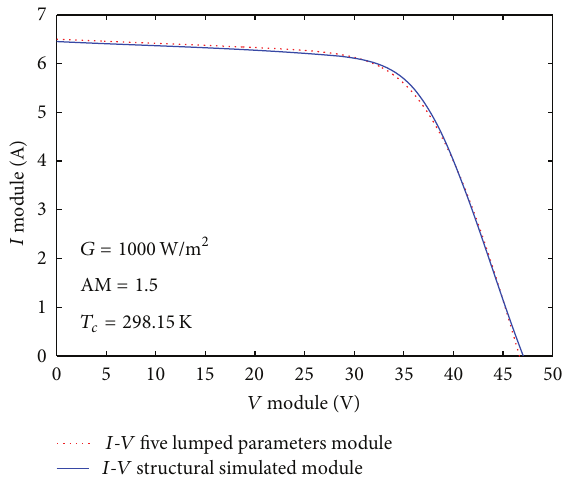
Figure 11: 𝐼 - 𝑉 curve from the five parameter model and structural model with parasitic